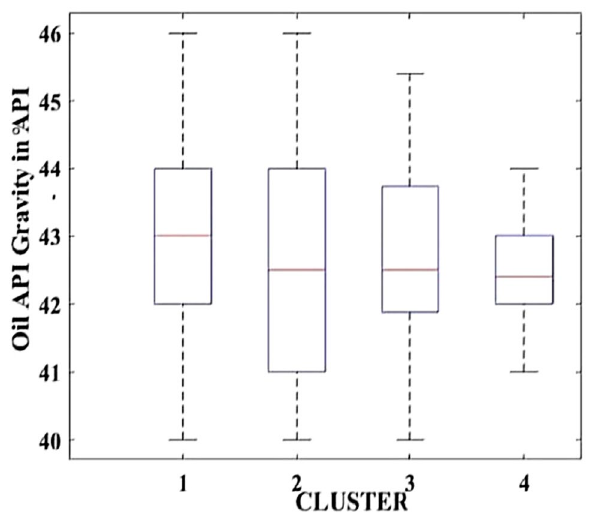
Figure 15. Initial 24-h period oil API